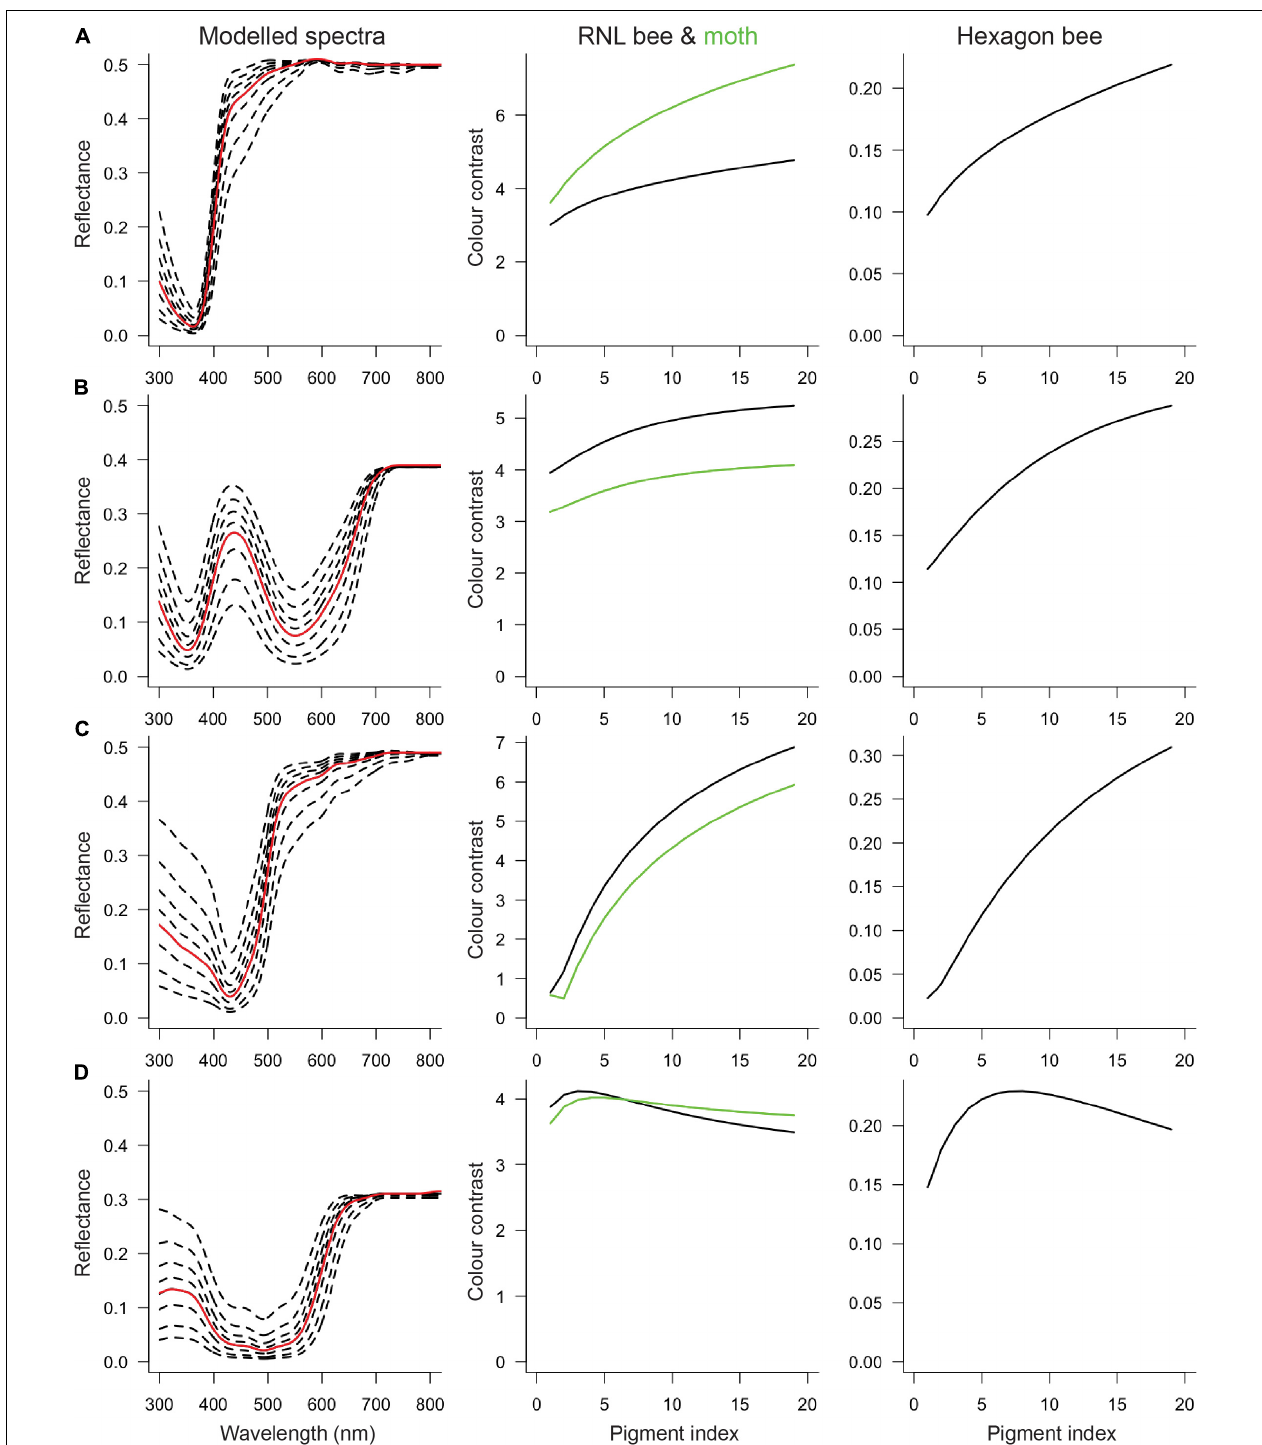
FIGURE 4 | Color contrast for reflectance spectra with different degrees of modulation. The first column shows the measured reflectance spectra (red curve) and a selection of the modeled cases (dashed curves), including the most weakly and strongly modulated spectra. The measured reflectance is identical to the fifth modeled spectrum, so the empirical color contrast values are at pigment index = 5. The second column shows bee (black) and moth (green) color contrast calculated with the receptor noise-limited (RNL) model. The third column shows bee color contrast calculated with the hexagon model. (A) Silene latifolia , (B) Nolana paradoxa , (C) Oenothera macrocarpa , and (D) Papaver rhoeas .